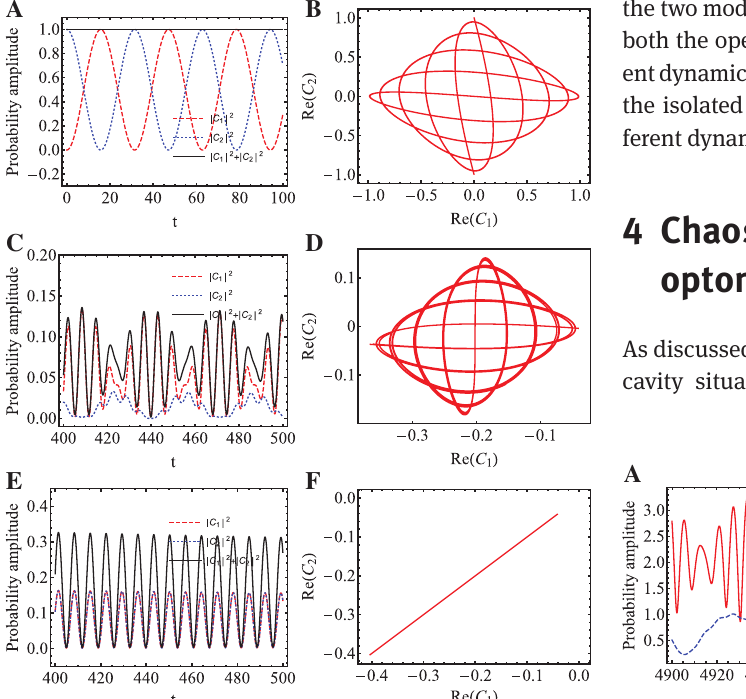
Figure 3: (A) The evolution of the two state probability amplitudes over time. The solid red line corresponds to the state |1, 0, 0⟩ and blue dashed line corresponds to the state |1, 0, 0⟩. (B) The Poincaré section of the two